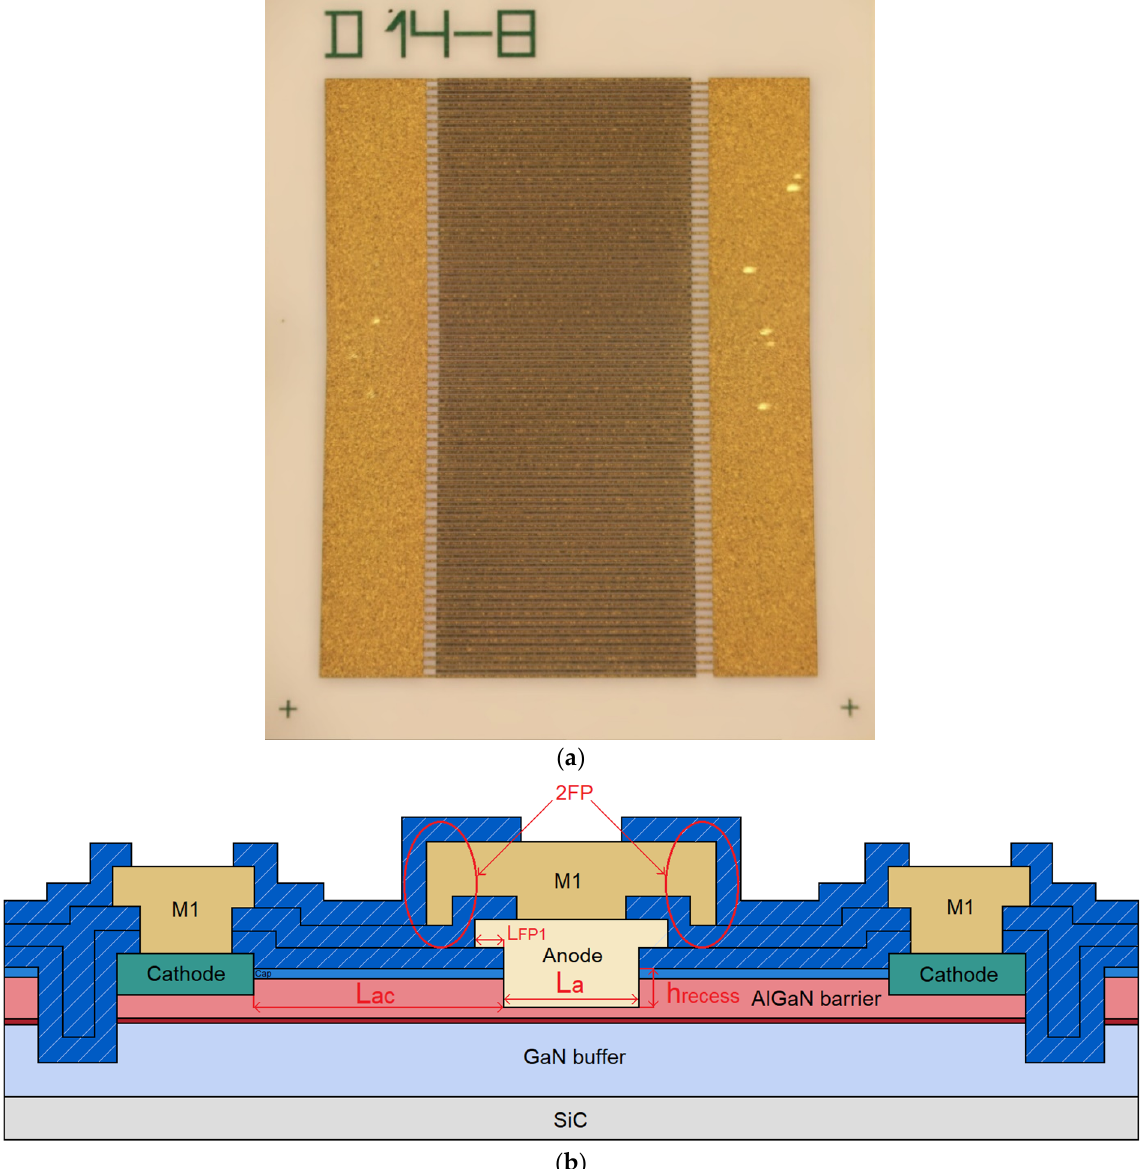
Figure 2. AlGaN/GaN lateral SBD construction: ( a ) Top-view microscopic image of performance of an SBD with total anode width W = 60 mm; ( b ) Cross-sectional schematics of an SBD with two field plates.